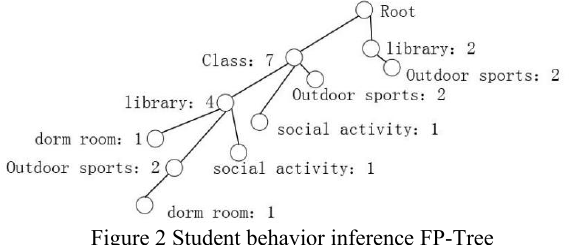
Figure 2 Student behavior inference